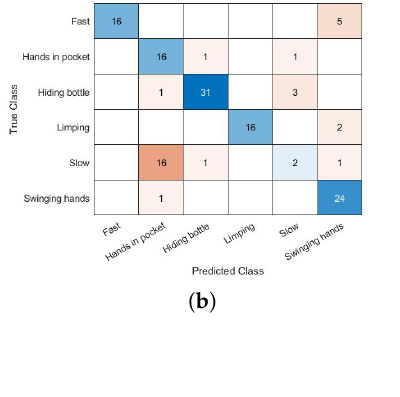
Figure 15. Classification accuracy among six different walking patterns. ( a ) Micro-Doppler signatures- based classification accuracy; ( b ) interferometric signatures-based classification accuracy; ( c ) dual micro-motion signatures-based classification accuracy.